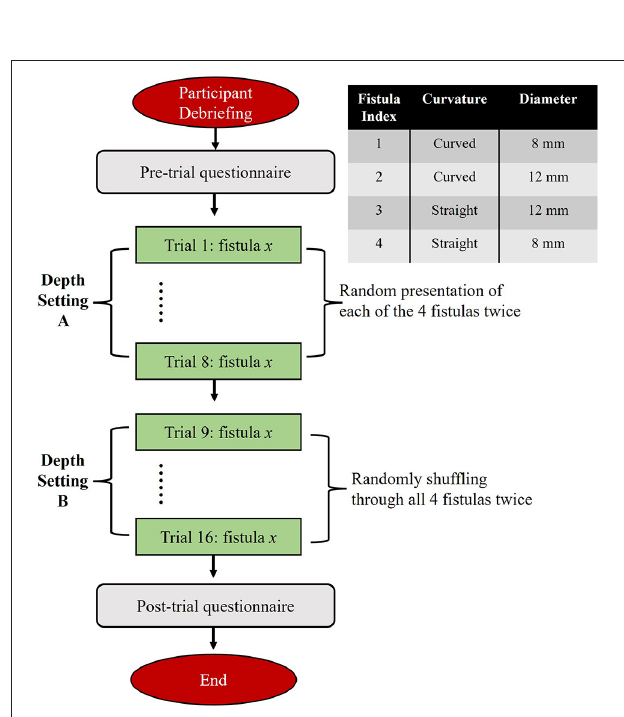
FIGURE 2 | Flow chart of the experimental